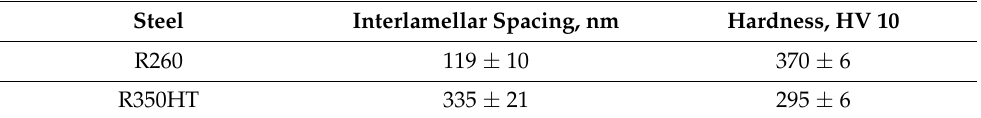
Table 3. Vickers hardness and interlayer spacing of rail